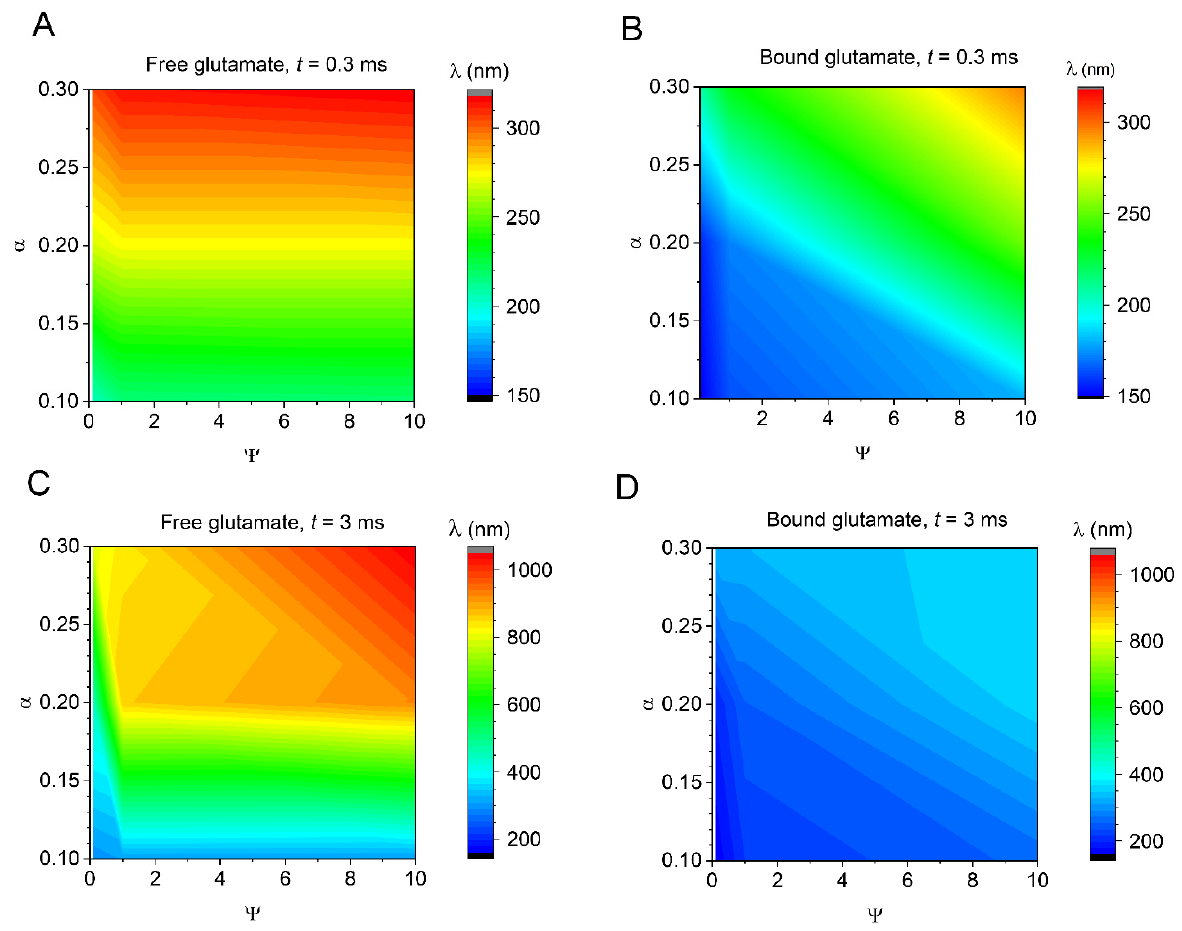
Figure 2. The influence of binding efficacy and extracellular space fraction on the glutamate escape profile. ( A ) Length constant λ (distance at 1/ e top value near at the synaptic cleft boundary) of the extracellular free-glutamate concentration profile, false-colour coded (scale bar shown), in relation to the range of Ψ and α , as indicated; time point, 0.3 ms post-release. ( B ) Same as ( A ), but for transporter-bound glutamate. ( C ) Same as ( A ), but for the time point of 3 ms post-release. ( D ) Same as ( B ), but for the time point of 3 ms post-release.